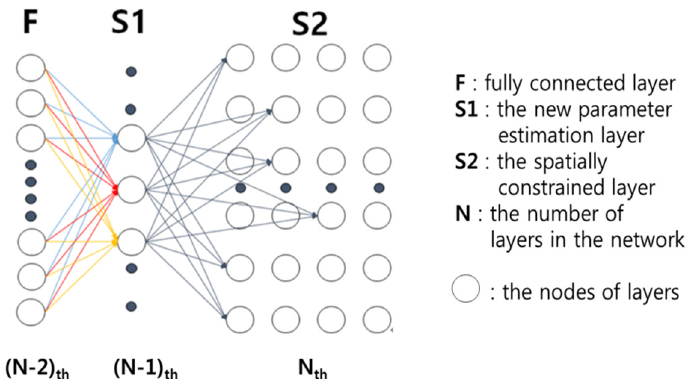
Figure 1. Structure of the spatially constrained convolutional neural network (SC-CNN).